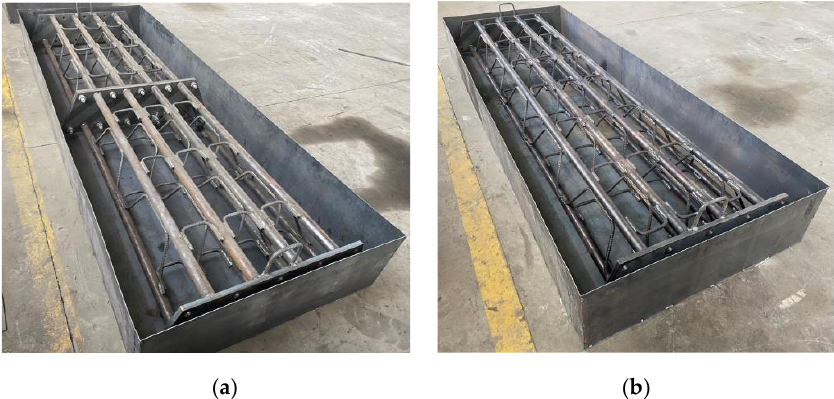
Figure 3. Before pouring of the spatial reticulated grid components. ( a ) The bolted end-plate joint component and ( b ) the jointless component.